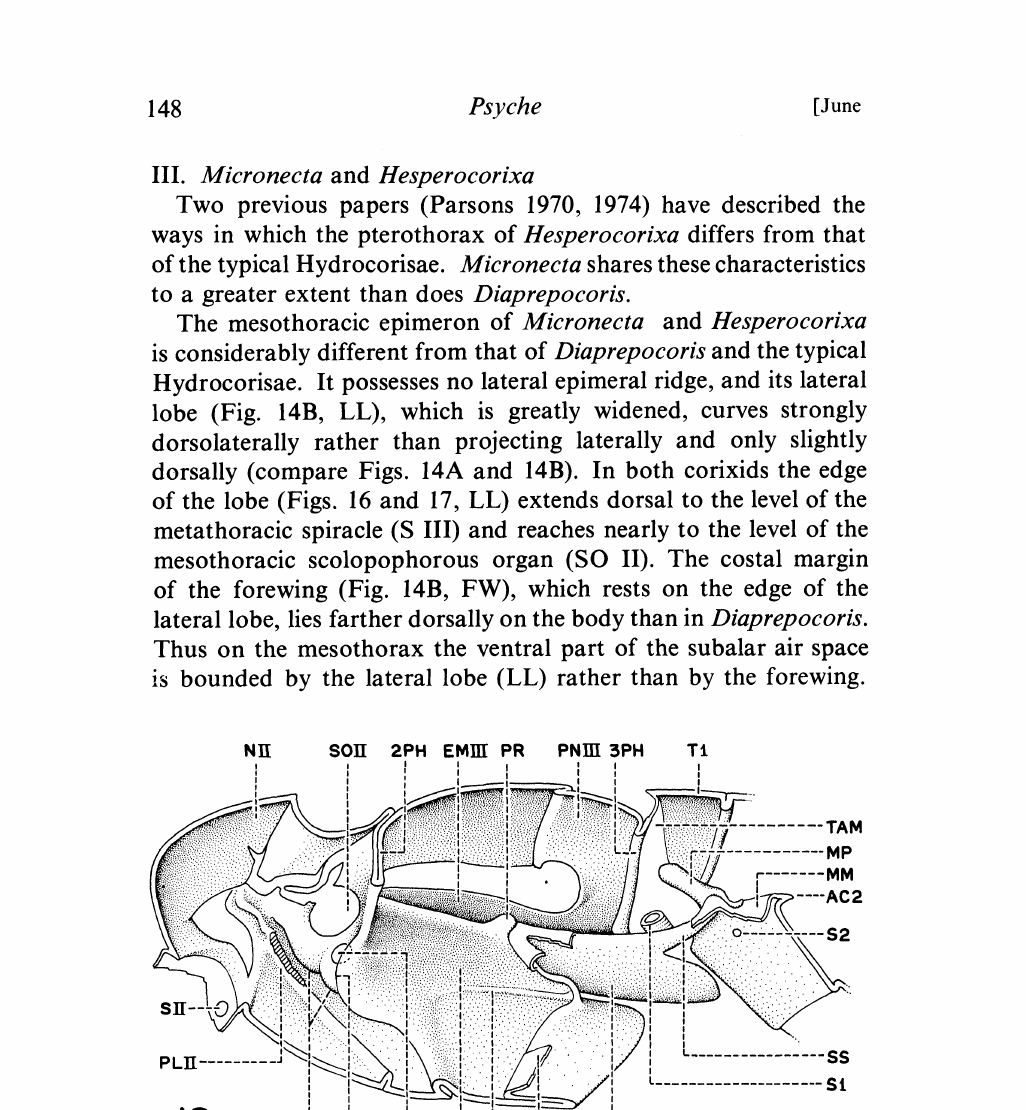
Fig. 18. D. zealandiae; internal view of pterothorax and anterior abdomen, cut parasagittally lateral to mesocoxa. Cross-hatched cut edge of mesothoracic pleural ridge (PL II) indicates base of pleural apophysis (removed). Metacoxa and soft tissues removed; part of metacoxal membrane (MM) cut away to show sclerotized strip (SS) and inner wall of metathoracic epimeral lobe (EML). First abdominal spiracular trachea (S 1) emerges from spiracle lying in thoracico-abdominal mem- brane lateral to sclerotized